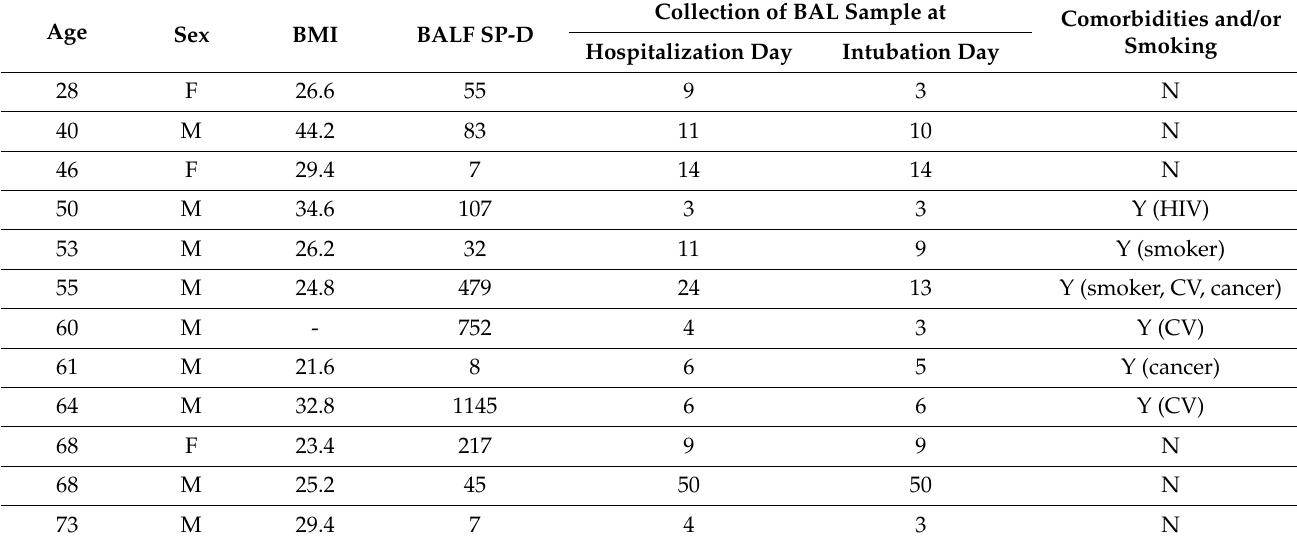
Table 1. Characteristics of patients, hospitalization and intubation time (days) at BAL sample